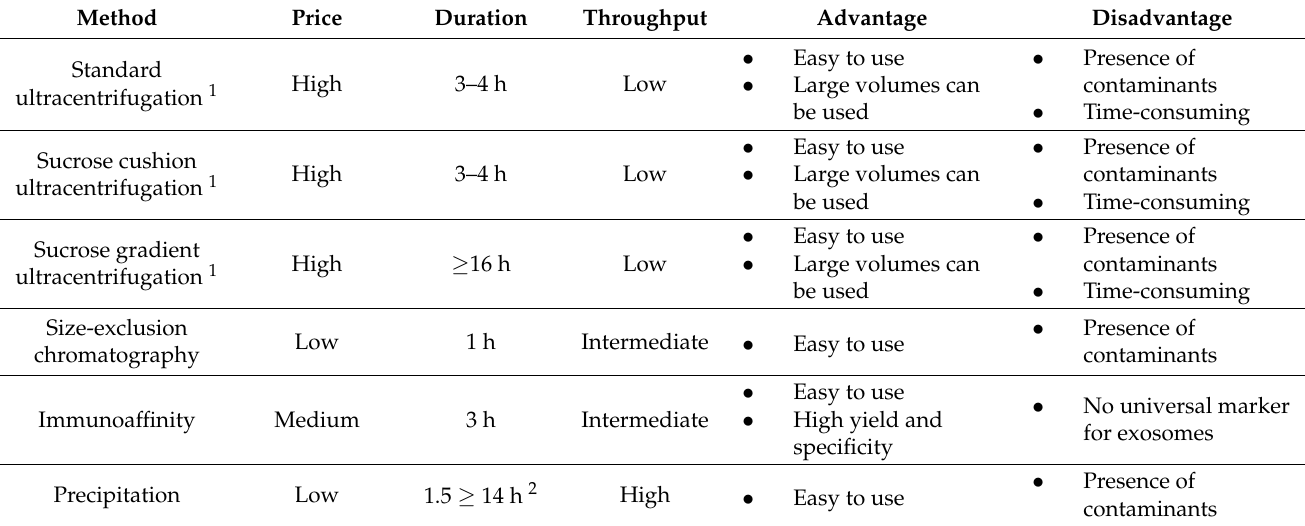
Table 3. Methods for exosomes